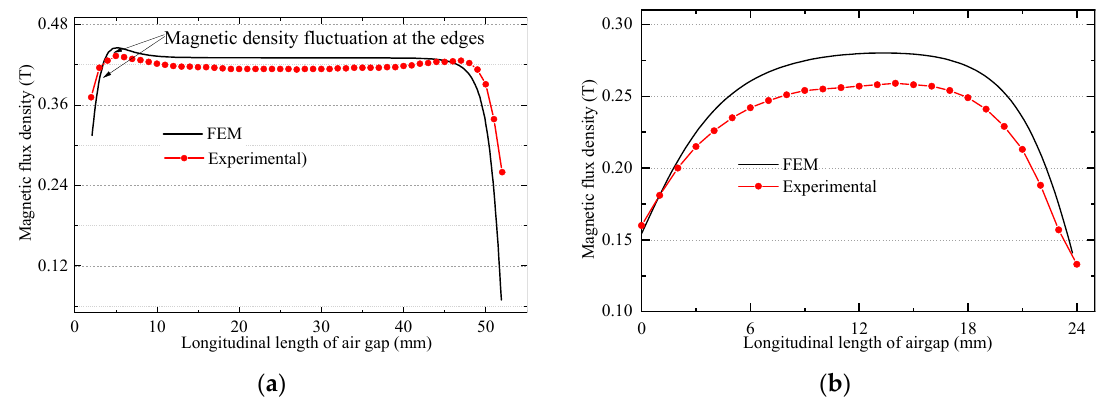
The airgap center flux density of the ejection unit and the driving unit is shown in Figure 16. The finite element method (FEM) results are larger than the experimental results. The reason is that the key parameters in the FEM soft are not completely consistent with the actual values. The airgap flux density of the ejection unit is large and uniform due to unique double magnetic circuits. The average flux density at the airgap center of the ejection unit is about 0.424T. Because of the single-sided arrangement of the permanent magnet, the airgap magnetic density at the center of the driving unit is large and decreases to both sides. The average flux density at the airgap center of the driving unit is about 0.23T.